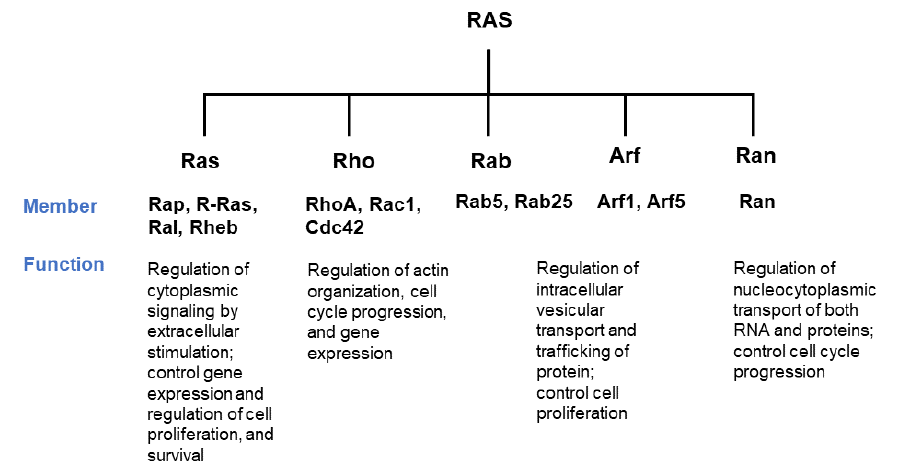
Figure 1. The branched tree of RAS superfamily. RAS superfamily comprises 150 human members and is divided into five different major branches. The Ras sarcoma (Ras) family comprises 36 members and has been the subject of intense research. The Ras homologous (Rho) family comprises 20 members, RhoA, Rac1, and Cdc42 being the best studied. The Ras-like proteins in brain (Rab), the largest branches of the superfamily, comprise 61 members. The ADP-ribosylation factor (Arf) family comprises 27 members; Rab and Arf families have similar functions. The Ras-like nuclear (Ran) family presents only one member [1,8].